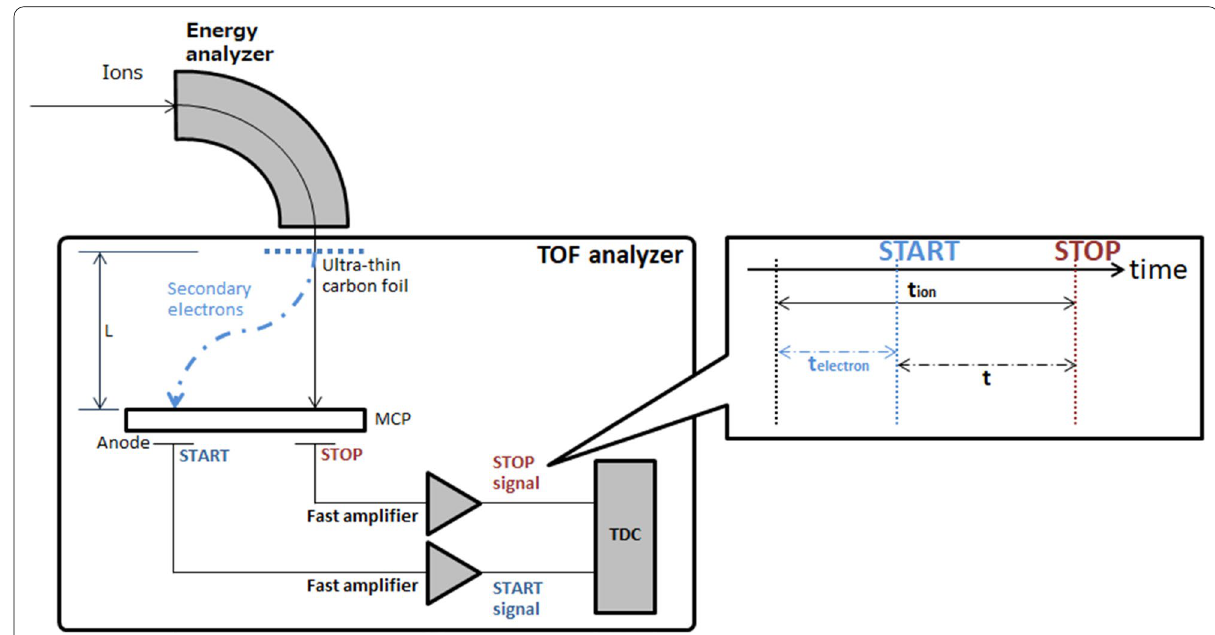
Fig. 1 Illustration of the principle of TOF-based ion energy-mass analysis. The energy analyzer determines the energy per charge. When ions pass through the ultra-thin carbon foil, secondary electrons are generated. The incoming ions and secondary electrons are separately detected by the MCP. The electron cloud emitted from the MCP is collected by the anode and becomes a current pulse. Fast amplifiers receive the current and supply “START” and “STOP” signals to the TDC. The particle velocity is calculated from the difference in the detection timing between the START and STOP signals. Finally, the particle mass-per-charge is determined from the energy-per-charge and particle velocity